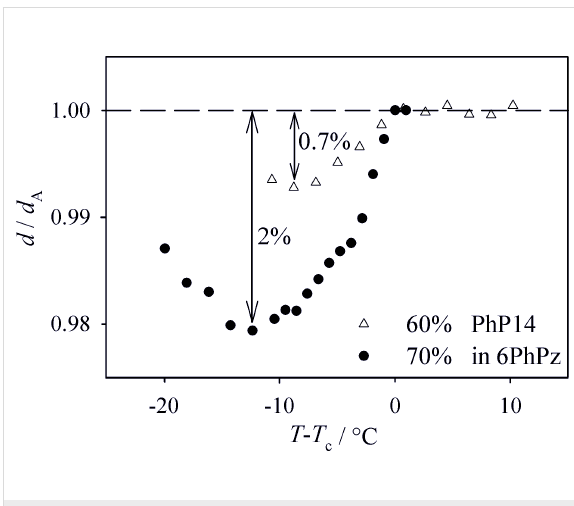
Figure 10: Reduced layer spacing vs temperature difference to the phase transition temperature for the mixtures with 60% and 70% PhP14 in 6PhPz . The layer shrinkage is only 2% for the 70% mixture and 0.7% for the 60% mixture,